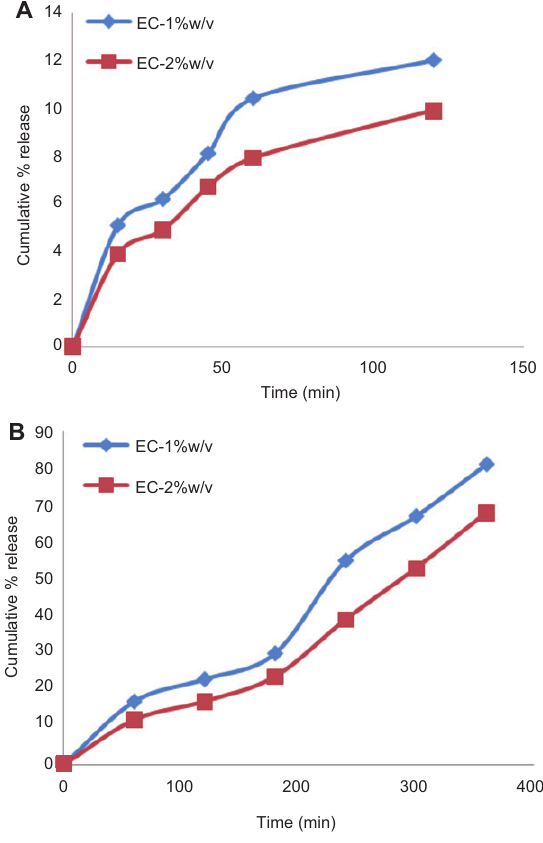
Figure 3 Release profiles of aspirin-loaded ethyl cellulose micro- particles: variation of surfactant (A) in pH 1.2 acid solutions and (B) in pH 7.4 PB